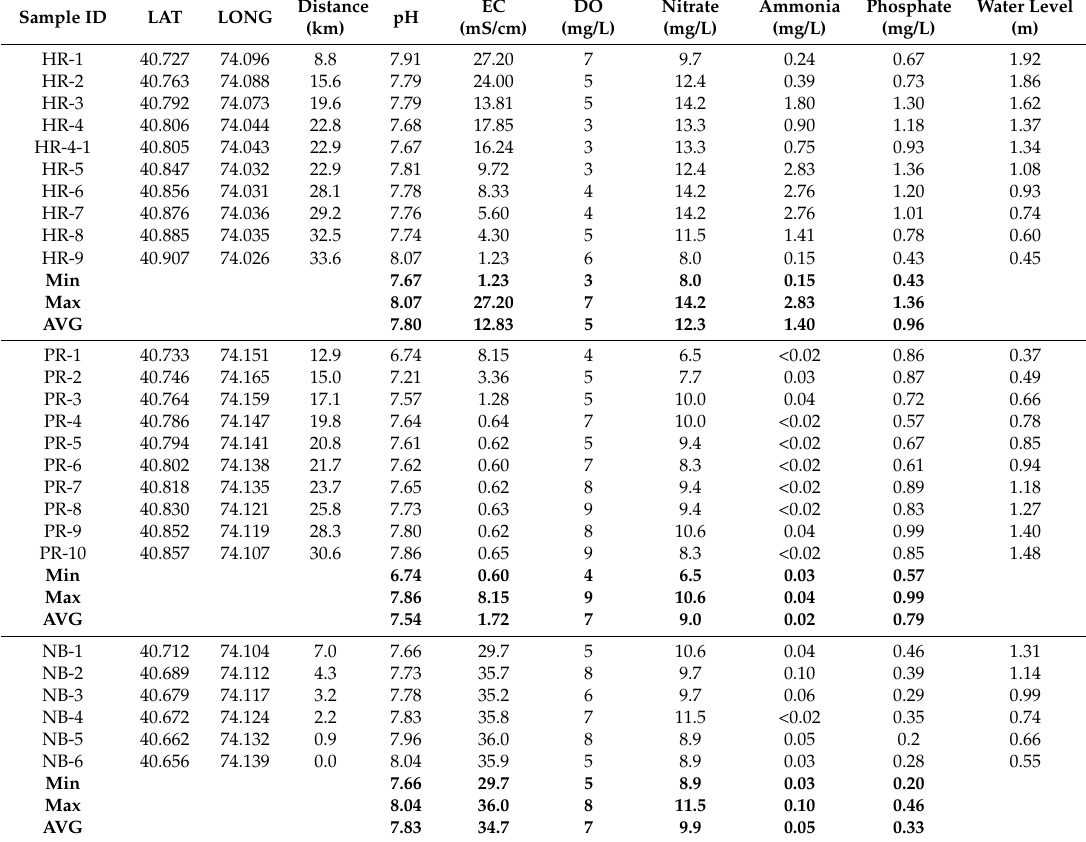
Table 1. Water quality data for samples collected from the Hackensack River (HR), the Passaic River (PR), and the Newark Bay (NB) in summer 2016. Distance (km) indicates the distance from NB-6 located near the mouth of the Newark Bay. Water level data (tidal datum: mean lower low water) at Bergen Point West Reach, NY, are from National Oceanic and Atmospheric Administration (https: